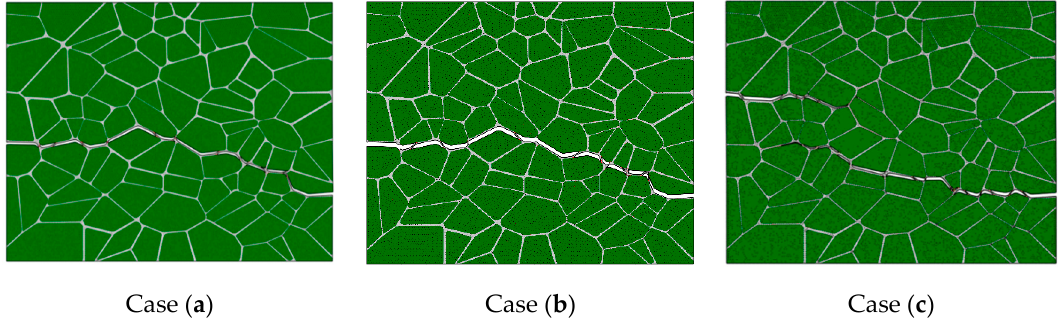
Figure 11. Simulation results for the three boundary conditions: ( a ) traction free vertical edges; ( b ) straight vertical edges; ( c ) periodic vertical edges; under tensile loading.